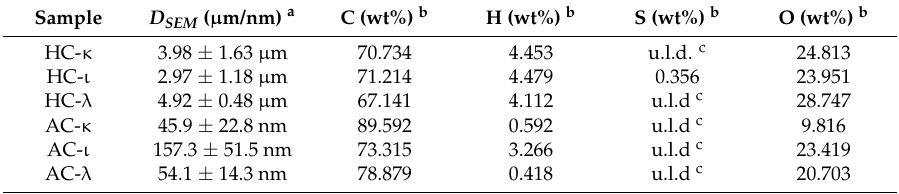
Table 1. Morphological and compositional properties of the hydrochars and activated carbons.